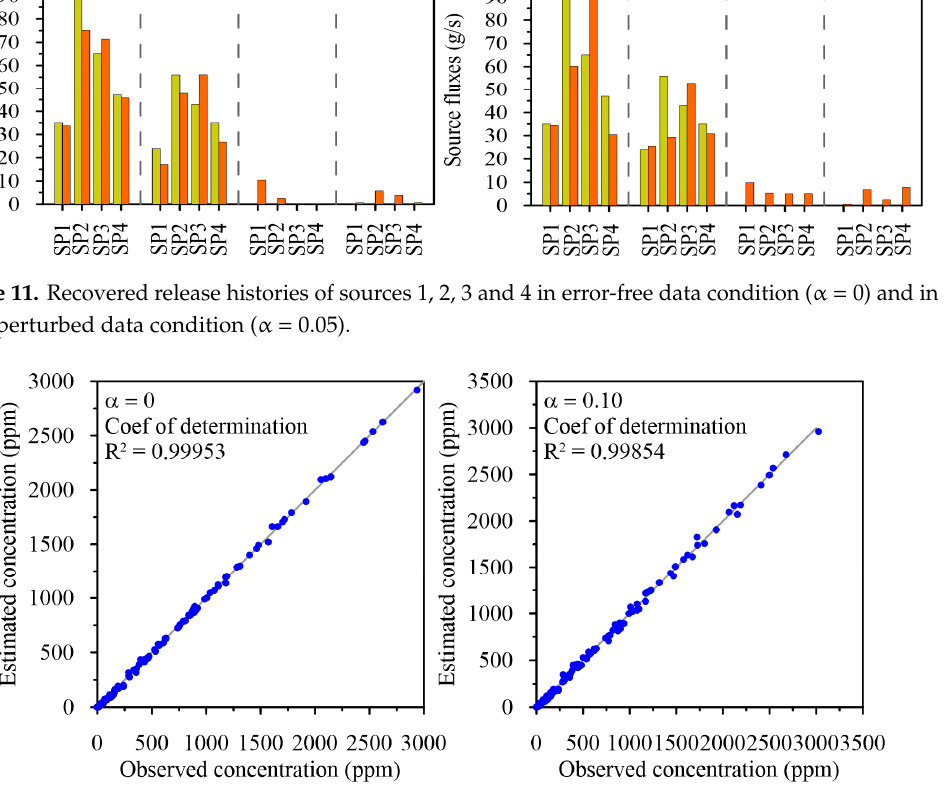
Figure 12. Estimated vs. observed concentration in error-free data condition ( α = 0) and in error- perturbed data condition ( α = 0.1).